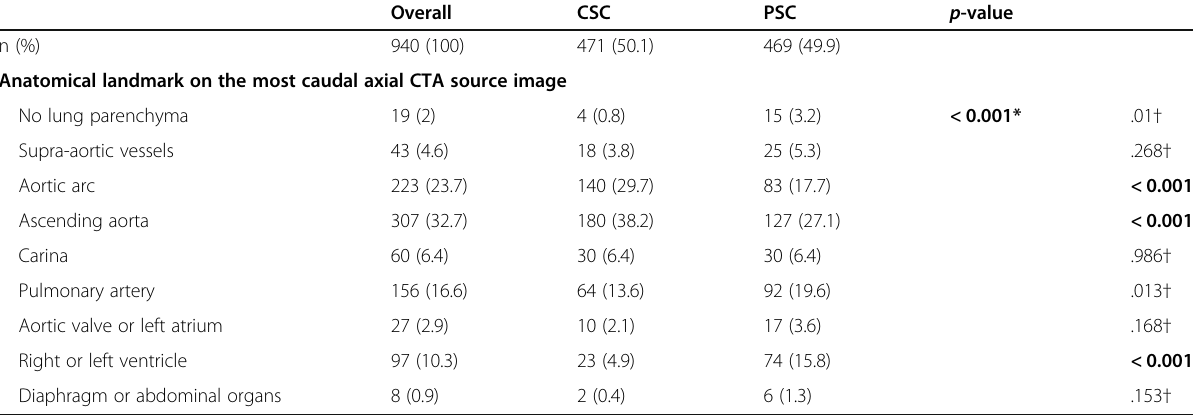
Table 2 Distribution of anatomical landmark covered by CTA Overall CSC PSC p -value Anatomical landmark on the most caudal axial CTA source image No lung